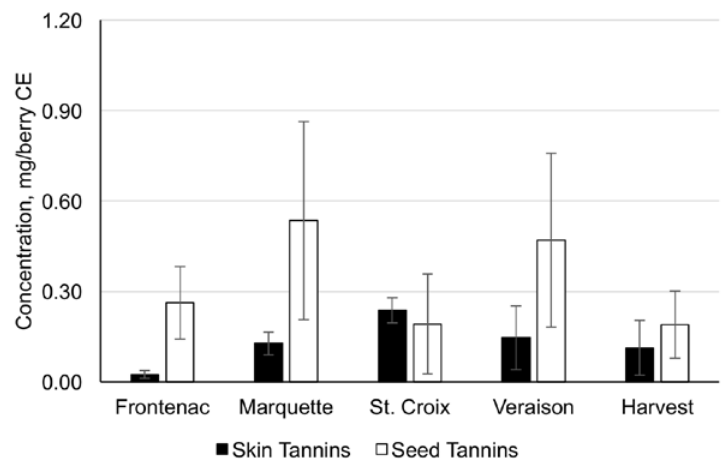
Figure 3. Summary statistics of mean values from the analysis of tannins extracted from skins and seeds, comparing Frontenac, Marquette, and St. Croix, and comparing veraison and harvest. Bars indicate the standard deviation.